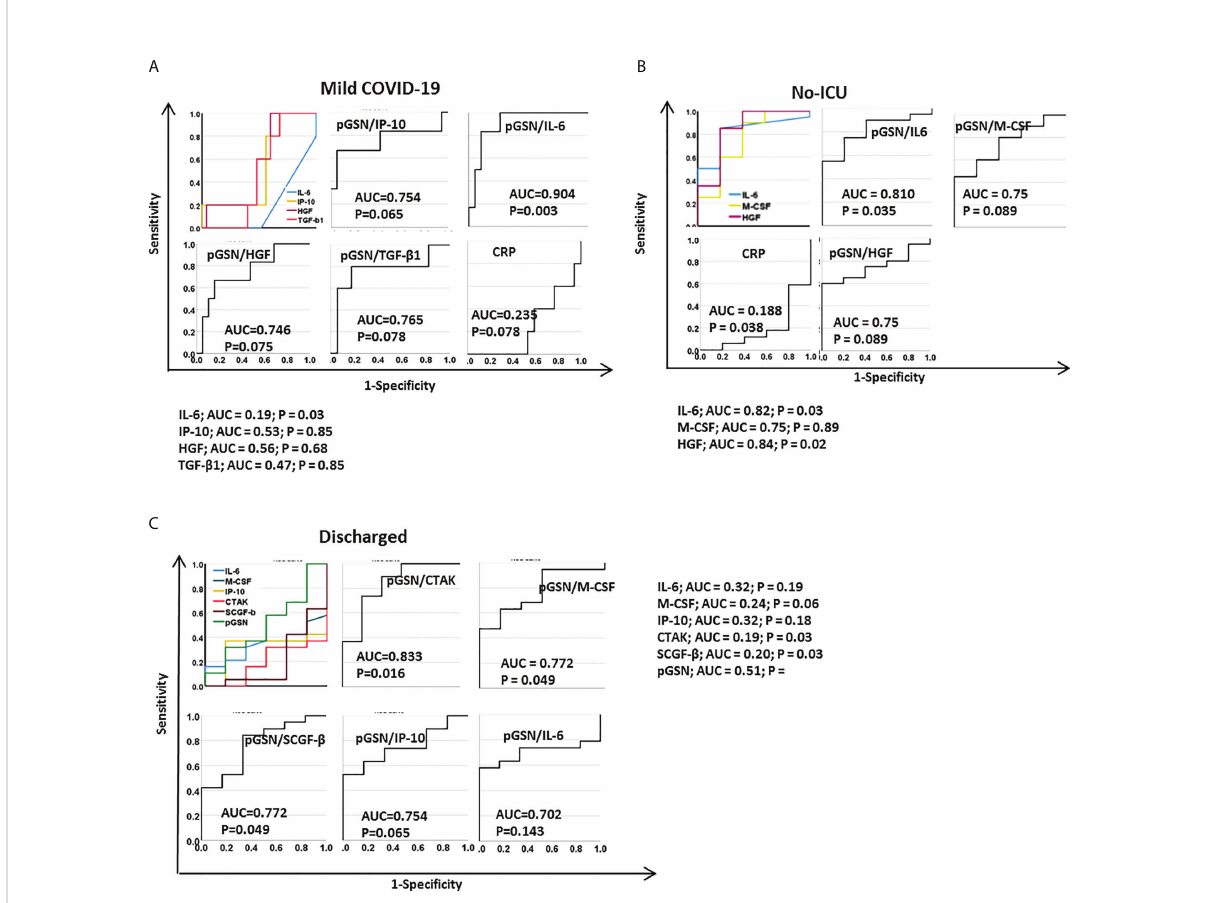
FIGURE 5 pGSN/IL-6 is a strong predictor of mild COVID-19 cases and favorable outcomes. ROC curves were used to assess the test performances of IL- 6, IP-10, HGF, TGF- b 1, M-CSF, CTAK, SCGF- b , CRP, pGSN, pGSN/IP-10, pGSN/IL-6, pGSN/HGF, pGSN/TGF- b , pGSN/M-CSF and pGSN/SCGF- b in predicting (A) mild COVID-19 cases, (B) no-ICU admissions and (C) discharged